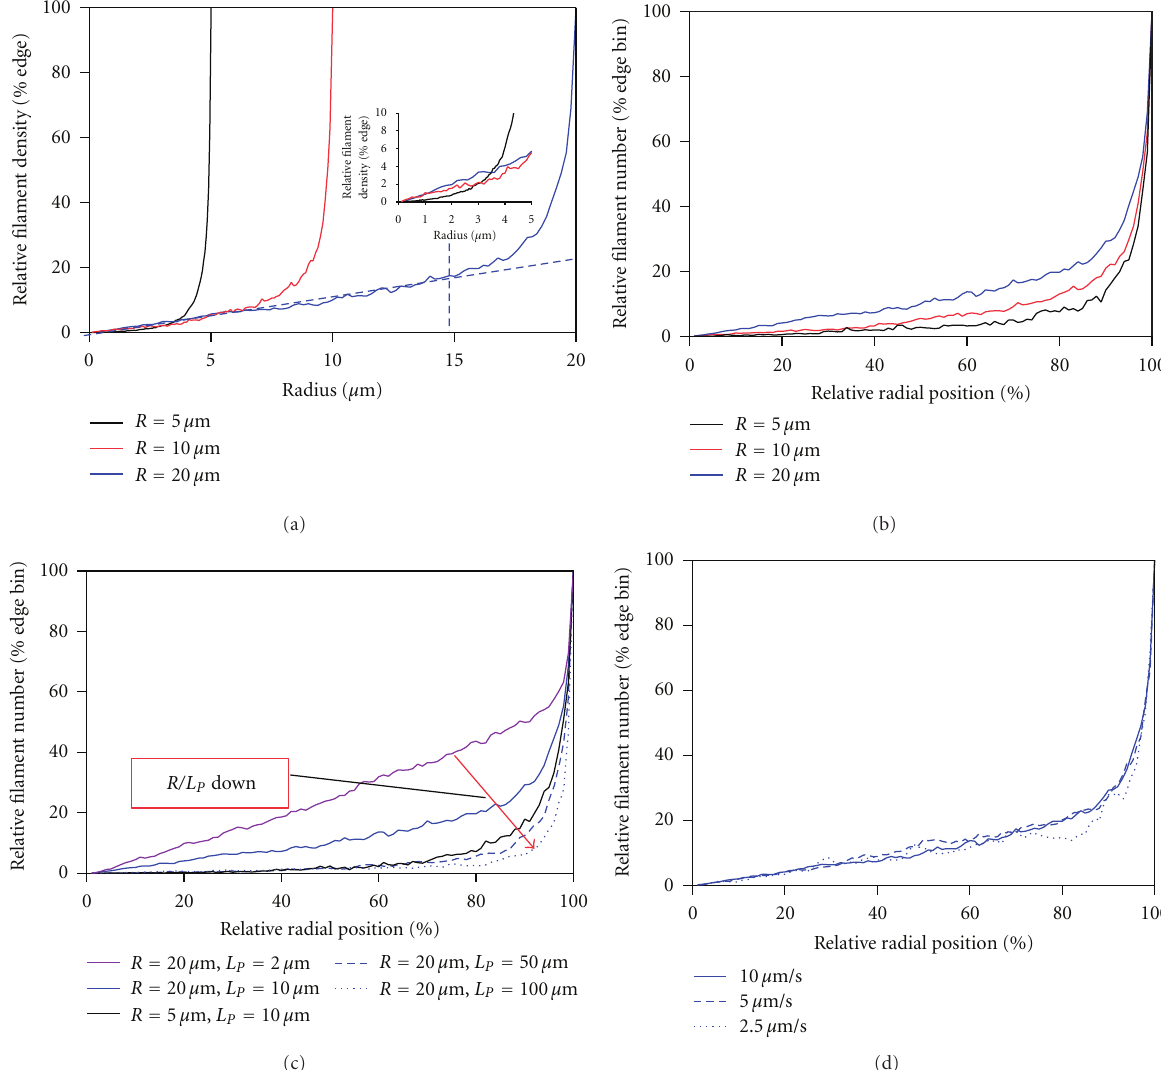
Figure 6: Radial filament distributions simulated for motor-propelled filaments. (a) The e ff ect of radius ( R ) of motility supporting region on the radial distribution of filaments. L p = 10 μ m, V f = 10 μ m/s, Δ t = 0 . 01s. Note, a small linear increase in filament number with increased radius related to the increase of circumference. Edge-tracing e ff ect corresponds to steep increase (in excess of the linear change) in number of filaments at periphery, for example, to the right of the dashed blue line for R = 20 μ m. Inset: part of diagram at the origin shown in greater detail. (b) The data in A, replotted with the radial position normalized to the radius of the motility supporting region. (c) Radial filament distributions for di ff erent L P − R combinations ( v f = 10 μ m/s and Δ t = 0 . 01 s). Note, increased edge-tracing with reduced R/L P ratio. That is, under these conditions, the edge peak in filament number is shifted outwards and has increased amplitude relative to the expected linear increase for all radial distances. (d) Radial filament distributions for di ff erent sliding velocities ( R = 20 μ m, L P = 10 μ m and Δ t = 0 . 01 s). Distributions obtained during time periods over which no apparent time dependence of the distributions was noted. The unrealistically low value of L P = 2 μ m (compared to actin filaments and microtubules) was included in (c) to more clearly illustrate the e ff ect of altered R/L P